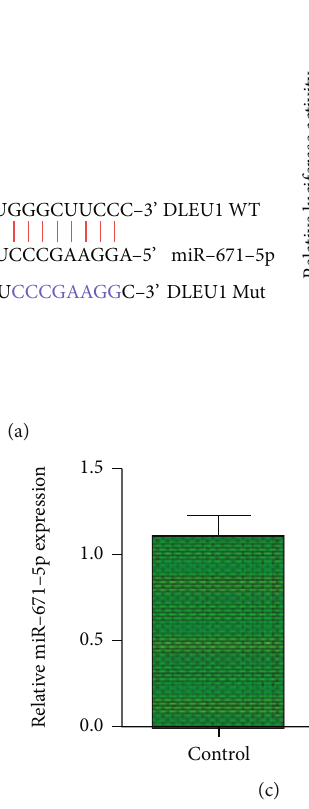
Figure 8: DLEU1 targeted miR-671-5p expression in chondrocytes. (a) Following the software (http://starbase.sysu.edu.cn/index.php), miR- 671-5p may be a potential combining target gene of the DLEU1. (b) Luciferase reporter analysis was carried out to study the relationship between miR-671-5p and DLEU1. The data indicated that cotransfection with miR-671-5p mimic and DLEU1-WT decreased luciferase activities when compared to miR-671-5p mimic and DLEU1-mut. (c) Overexpression of DLEU1 suppressed miR-671-5p expression in chondrocytes. ∗∗ p < 0 : 01